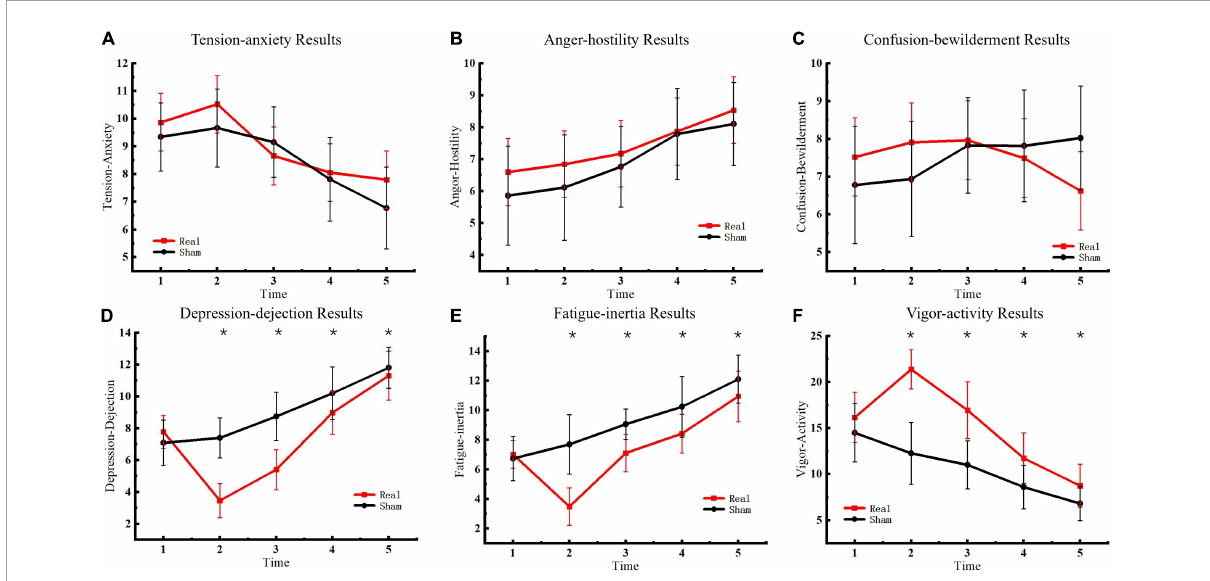
FIGURE3 Profile of mood states results. (A) Tension-anxiety results. (B) Anger-hostility results. (C) Confusion-bewilderment results. (D) Depression-dejection results. (E) Fatigue-inertia results. (F) Vigor-activity results. Asterisks indicate significant differences between real and sham tDCS conditions.